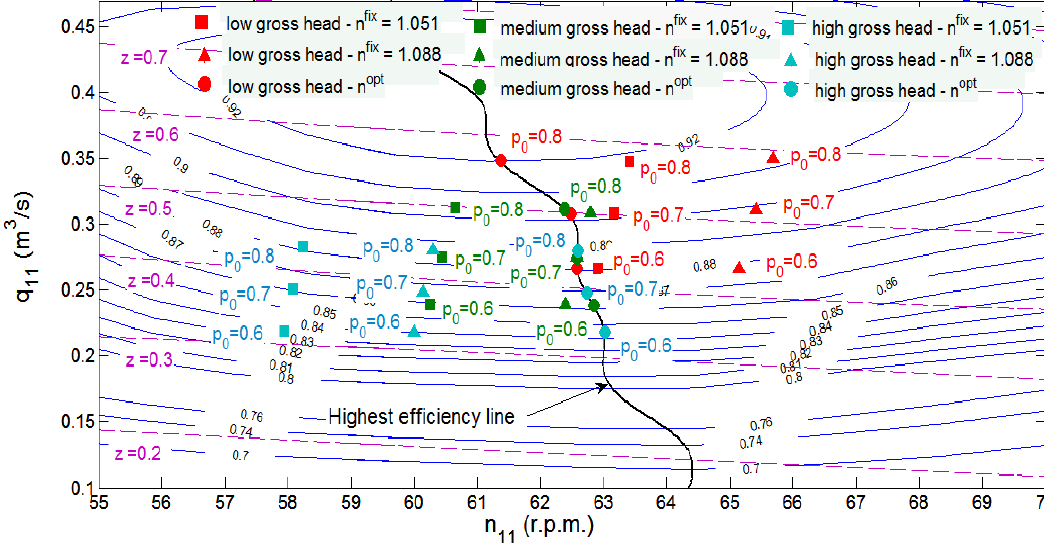
Figure 4. Pump ‐ turbine performance curves in generating mode; considered initial operating points superimposed in the curves.